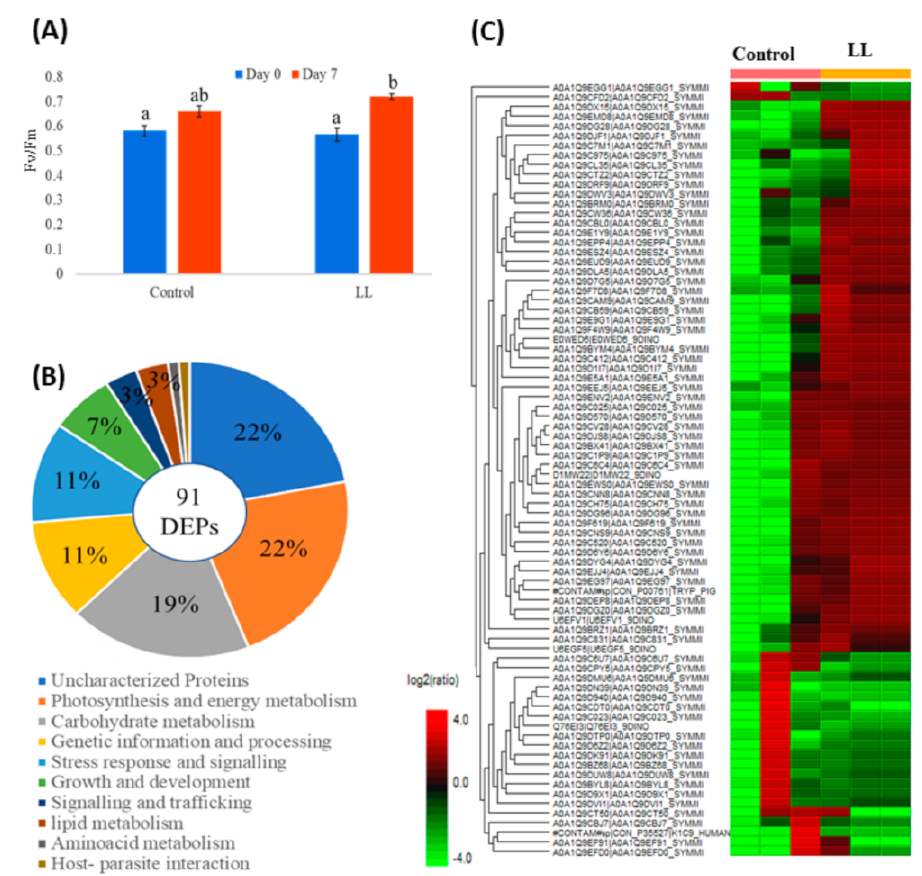
Figure 4. Proteome profiling in Symbiodinium tridacnidorum . Photosynthetic performance (Fv/Fm) ( A ); differential expressed proteins with their functional classification ( B ); and heat map of differen- tially expressed proteins (DEPs) ( C ) in Symbiodinium tridacnidorum grown under control (120 µ mol logical replicates ( n = 3). Different lower-case letters in ( A ) represent the statistical difference in photosynthetic performance ( p < 0.05) of Symbiodinium tridacnidorum cultures grown under